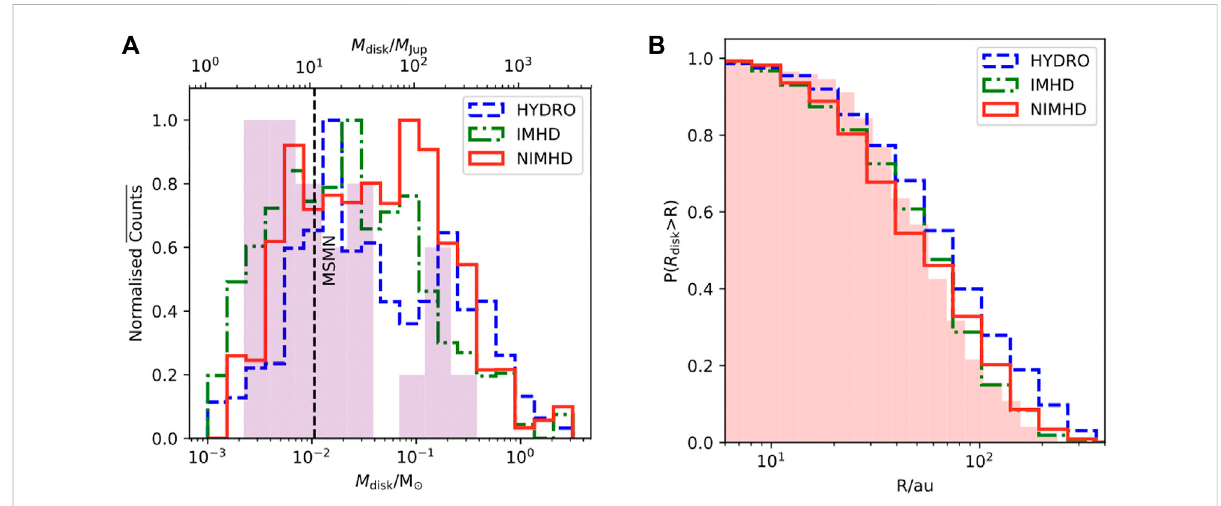
FIGURE 11 (A) Distributionsofdisk sizes obtained for thethree disk populationsynthesis models presented inLebreuillyetal. (2021)(note that thesizesare normalized so that their peak in the y -axis is 1). The mass of the minimum mass for the solar nebula (MSMN) is indicated as a dashed line. (B) Cumulative distribution function of disk radius for the three models presented in Lebreuilly et al.